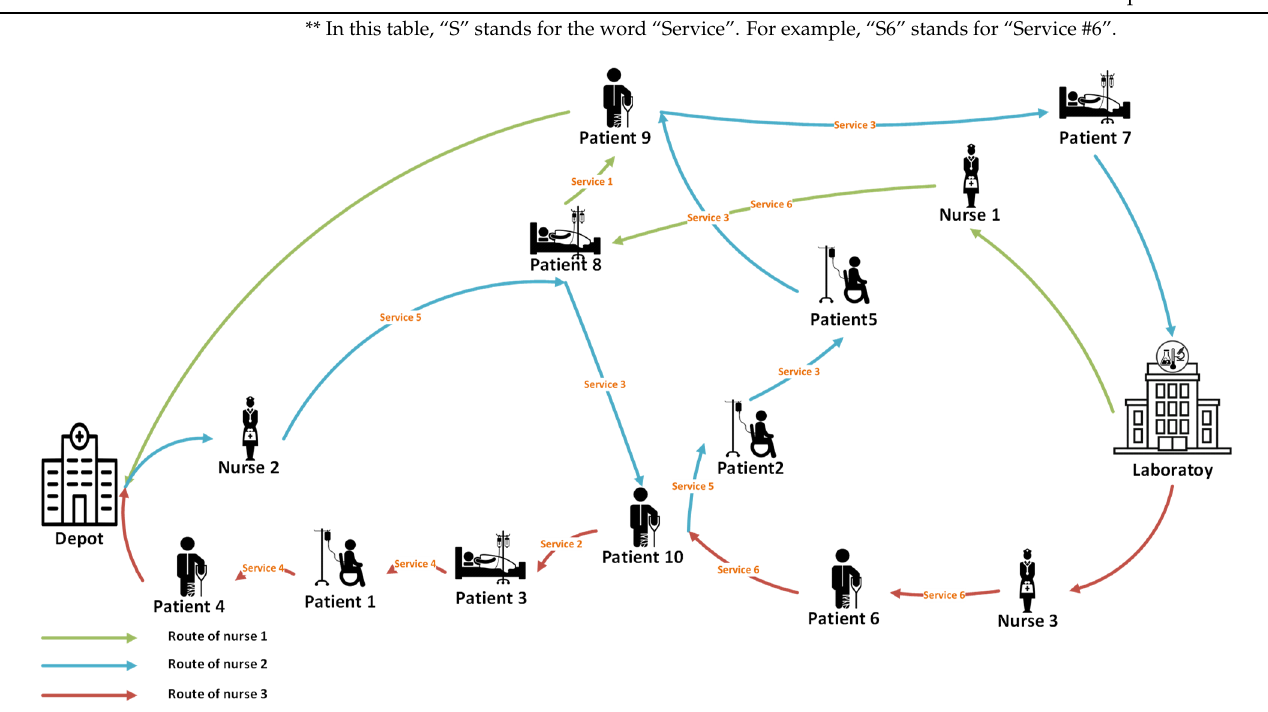
Table 3. Characteristics of the benchmark instances .